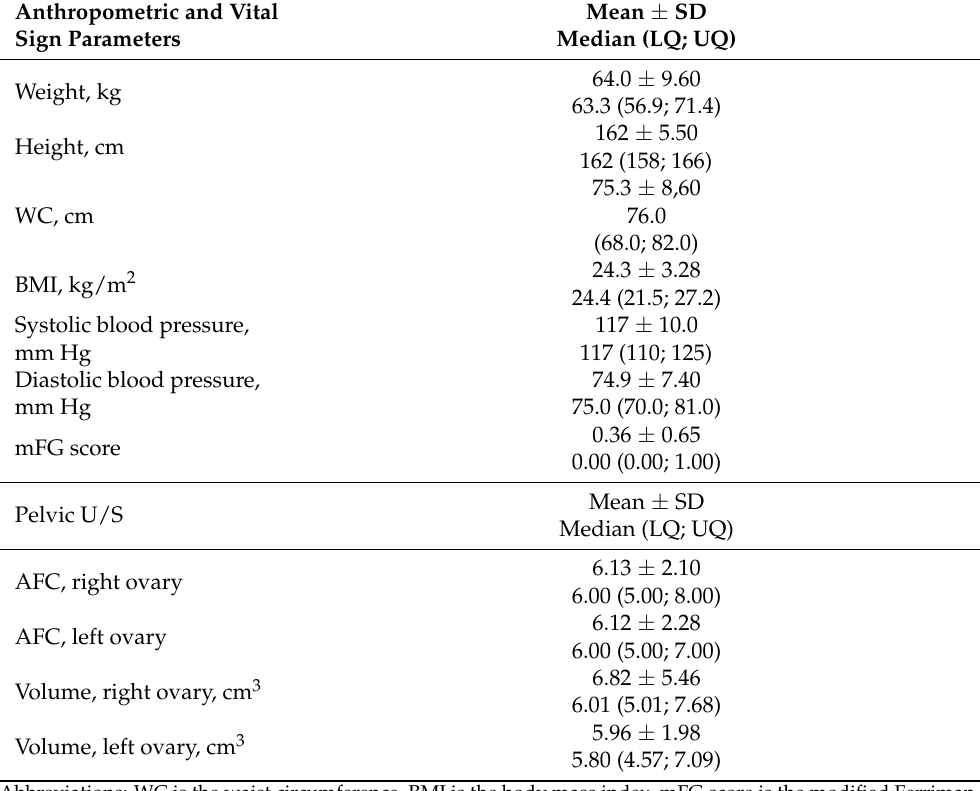
Table 3. Anthropometric, vital sign, and pelvic U/S parameters of healthy controls. Anthropometric and